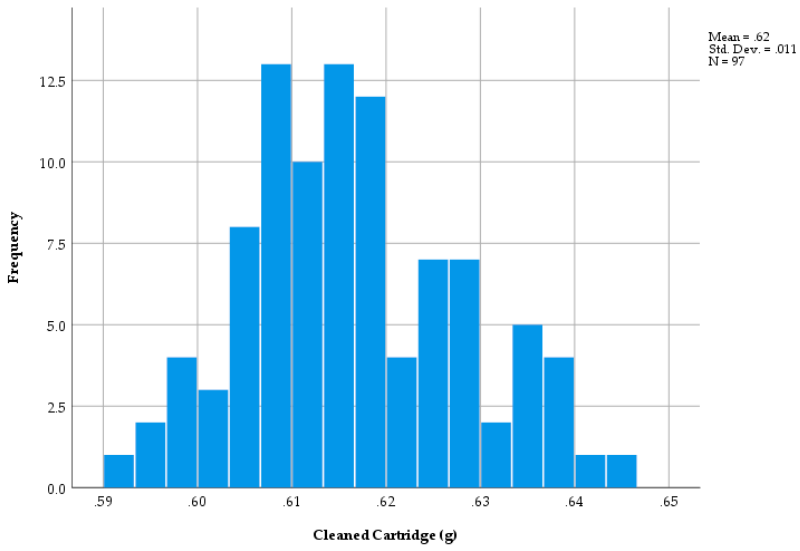
Figure 9. The weight distribution of the cleaned cases (g).